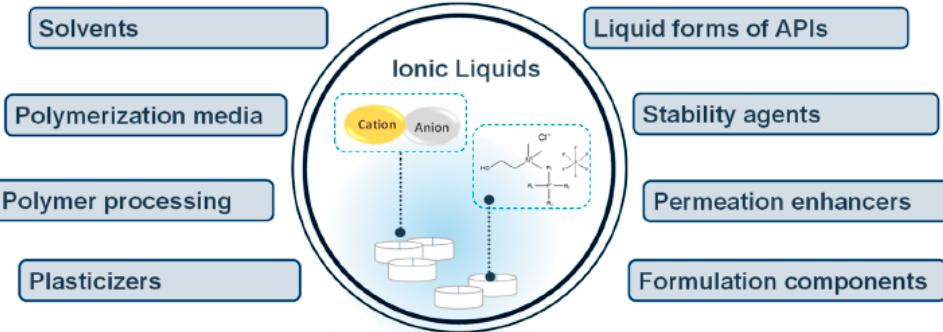
Figure 8. Morphology of electrospun polymer fiber mats: ( a ) randomly oriented neat PVDF, ( b ) aligned neat PVDF fibers, ( c ) randomly oriented PVDF with 5 wt% IL, and ( d ) aligned PVDF fibers with 5 wt% IL [Emim][TFSI] obtained. Reprinted with permission of [117].